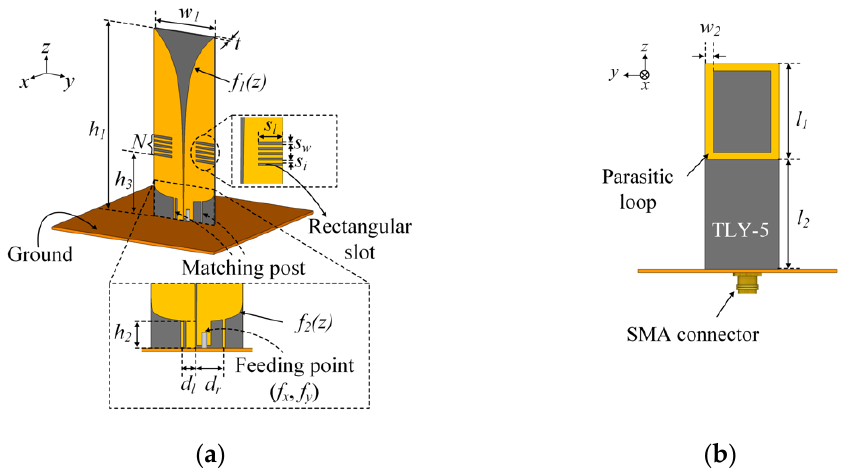
Figure 1. Geometry of the proposed printed dipole antenna: ( a ) isometric view; ( b ) back view.